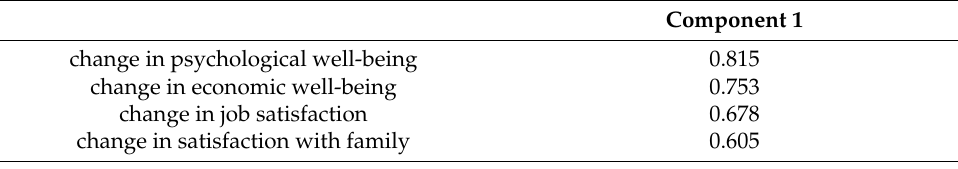
Table 7. Component matrix of PCA.